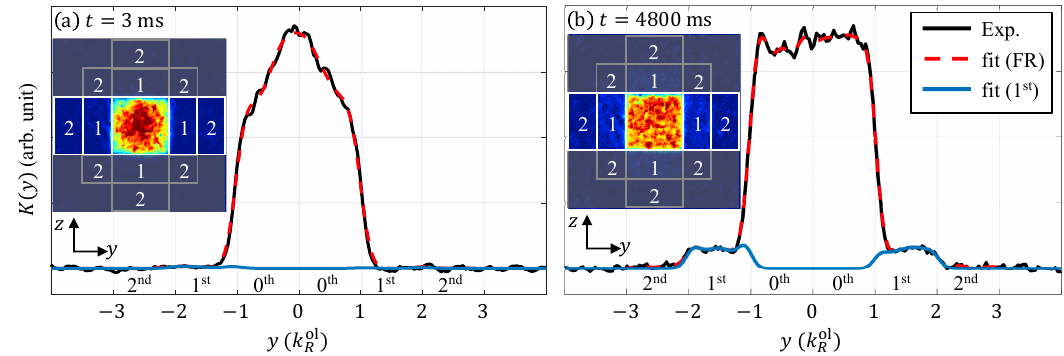
Figure 14: Evaluating the fractions of atoms in transverse states. The method is illus- trated with two examples of the band-mapping images taken at (a) the beginning and (b) the end of dynamical evolution ( N = 130). By integrating the band-mapped dis- tribution in the unshaded region, we obtain the 1D distributions (black solid curves) and fit them to a summation of a set of Gaussian curves in the full range (FR) (red dashed curves). The fitted distribution of the first excited state is shown in blue, separated from the ground state and the second excited